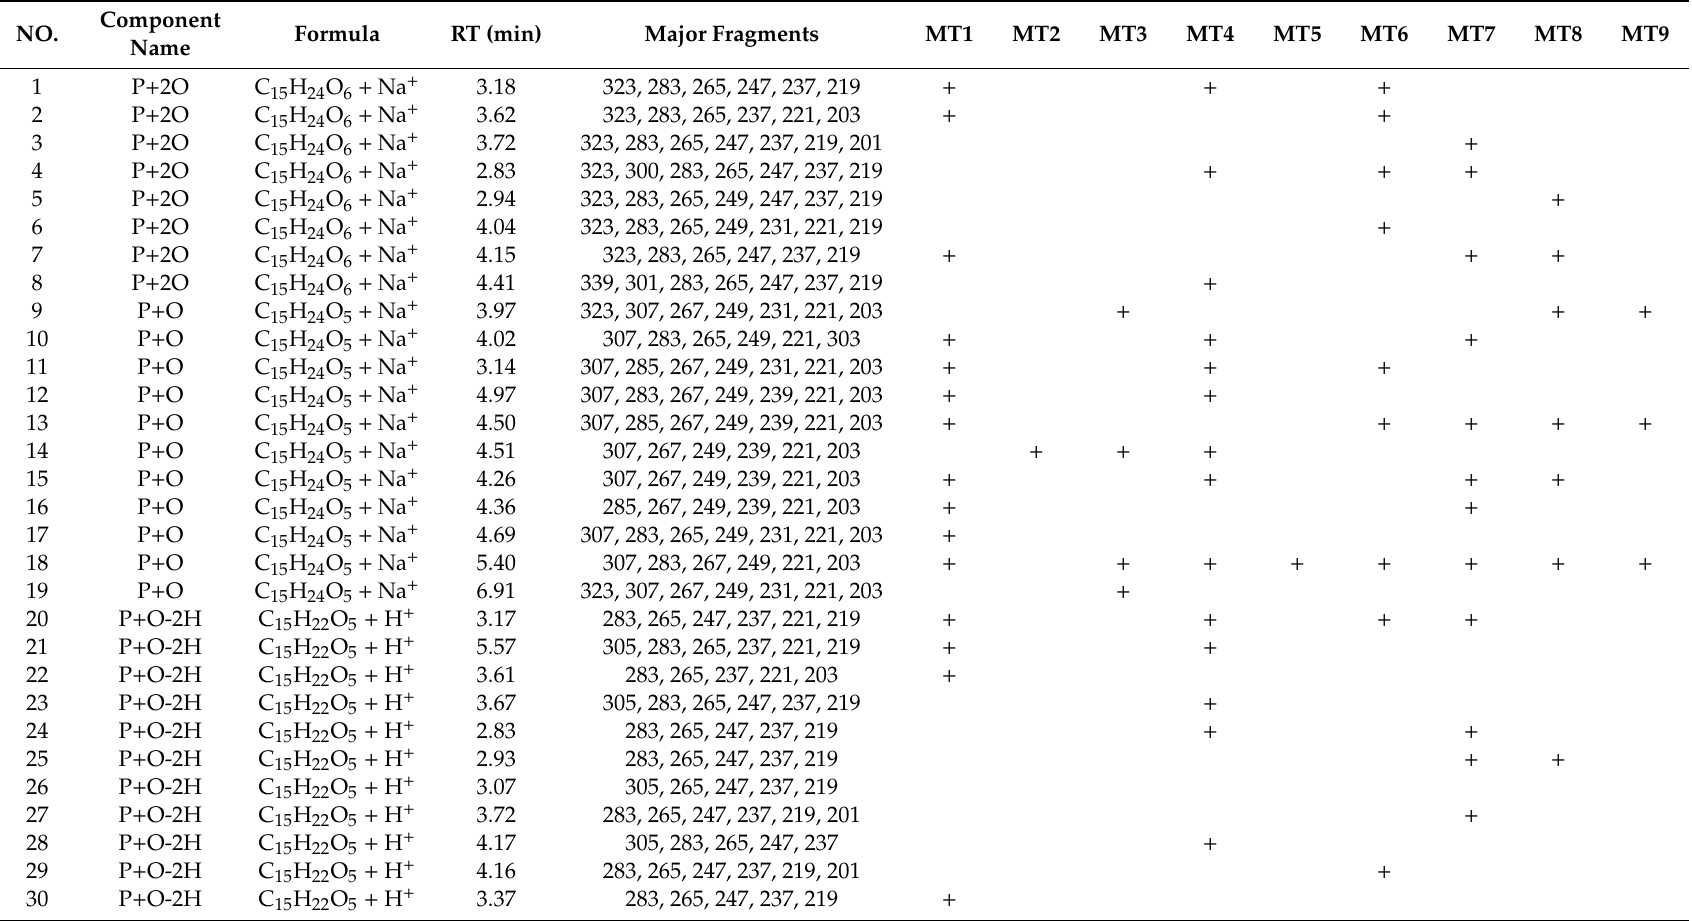
Table 1. Summary of microbial transformation products of